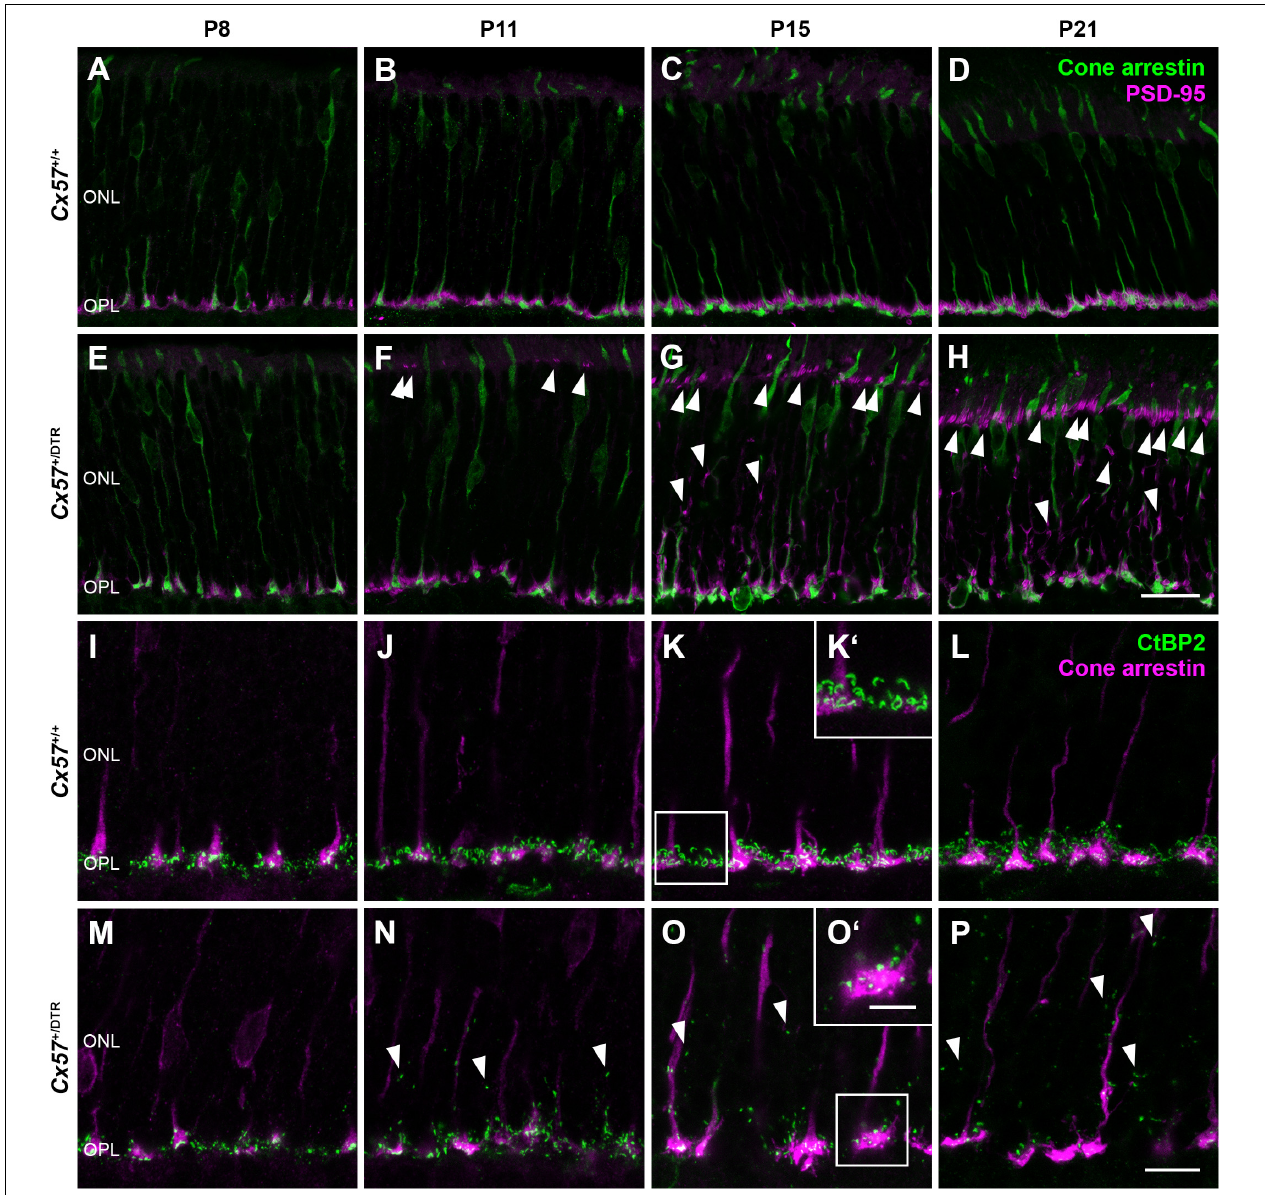
FIGURE 3 | Retraction of rod terminals and disrupted ribbon assembly following early postnatal horizontal cell ablation. (A–H) Double labeling of retinal sections from Cx57 + / + and Cx57 + / DTR mice for cone arrestin (green), a marker for cones, and PSD-95 (magenta), a marker for photoreceptor terminals. While PSD-95-positive photoreceptor terminals from Cx57 + / + mice were confined to the OPL (A–D) , Cx57 + / DTR mice showed a progressive retraction of rod terminals into the ONL beginning at P11 (arrowheads) (F–H) . Cones terminals retained their stratification in the OPL. (I–P) Immunostaining of Cx57 + / + and Cx57 + / DTR retinae with antibodies against the synaptic ribbon marker CtBP2 (green) and cone arrestin (magenta). (K‘,O‘) Magnified images of ribbons in panels (K,O) . Ribbons of horizontal cell-ablated mice were mainly restricted to the OPL and horseshoe shaped from P15 onward (I–L) . By contrast, horizontal cell-ablated mice showed ectopic ribbons in the ONL as early as P11 (arrowheads) (N–P) and CtBP2 labeling displayed a punctate pattern (M–P) . Scale bars, 20 µ m (H) , 10 µ m (P) and 5 µ m (O‘)